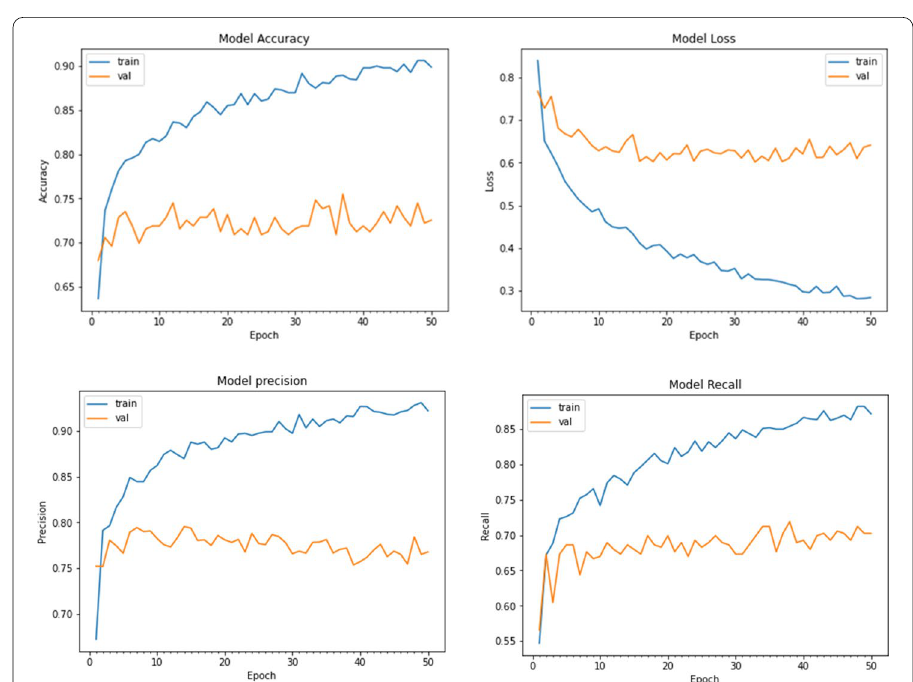
Fig. 5 Fine-tuned VGG-16 accuracy, loss, precision, and recall on three disasters earthquake, hurricane, and typhoon